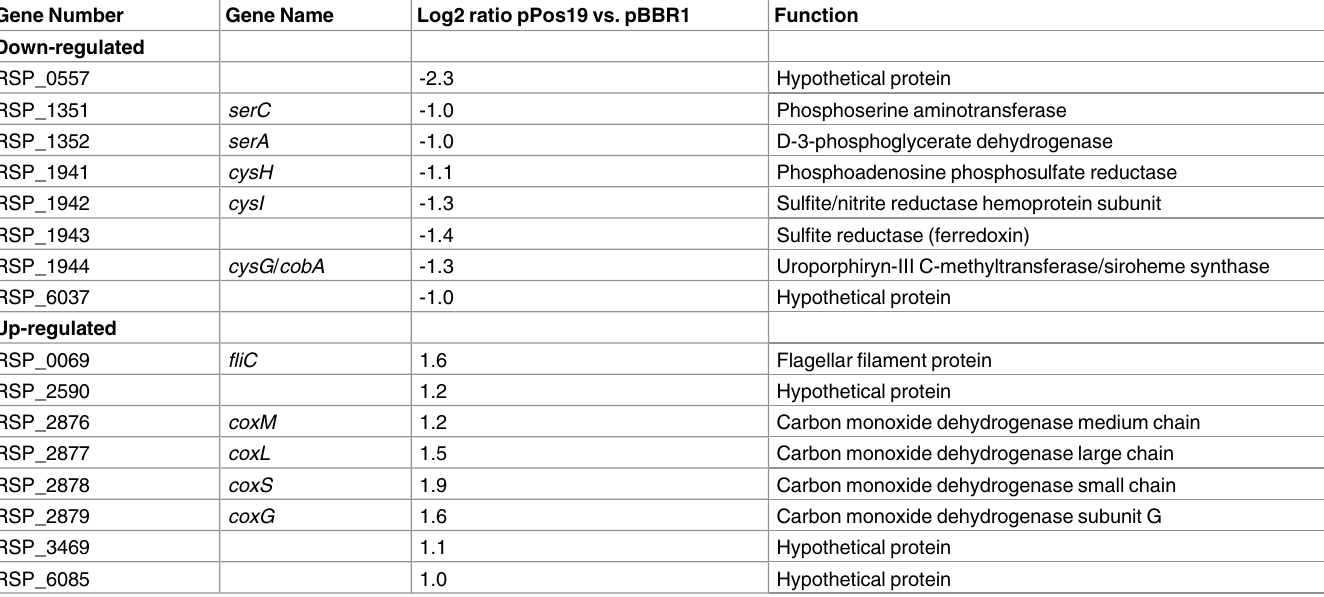
Table 1. Genes with differential mRNA levels upon Pos19 over-expression, log 2 ratios (cid:21) 1 and (cid:20)